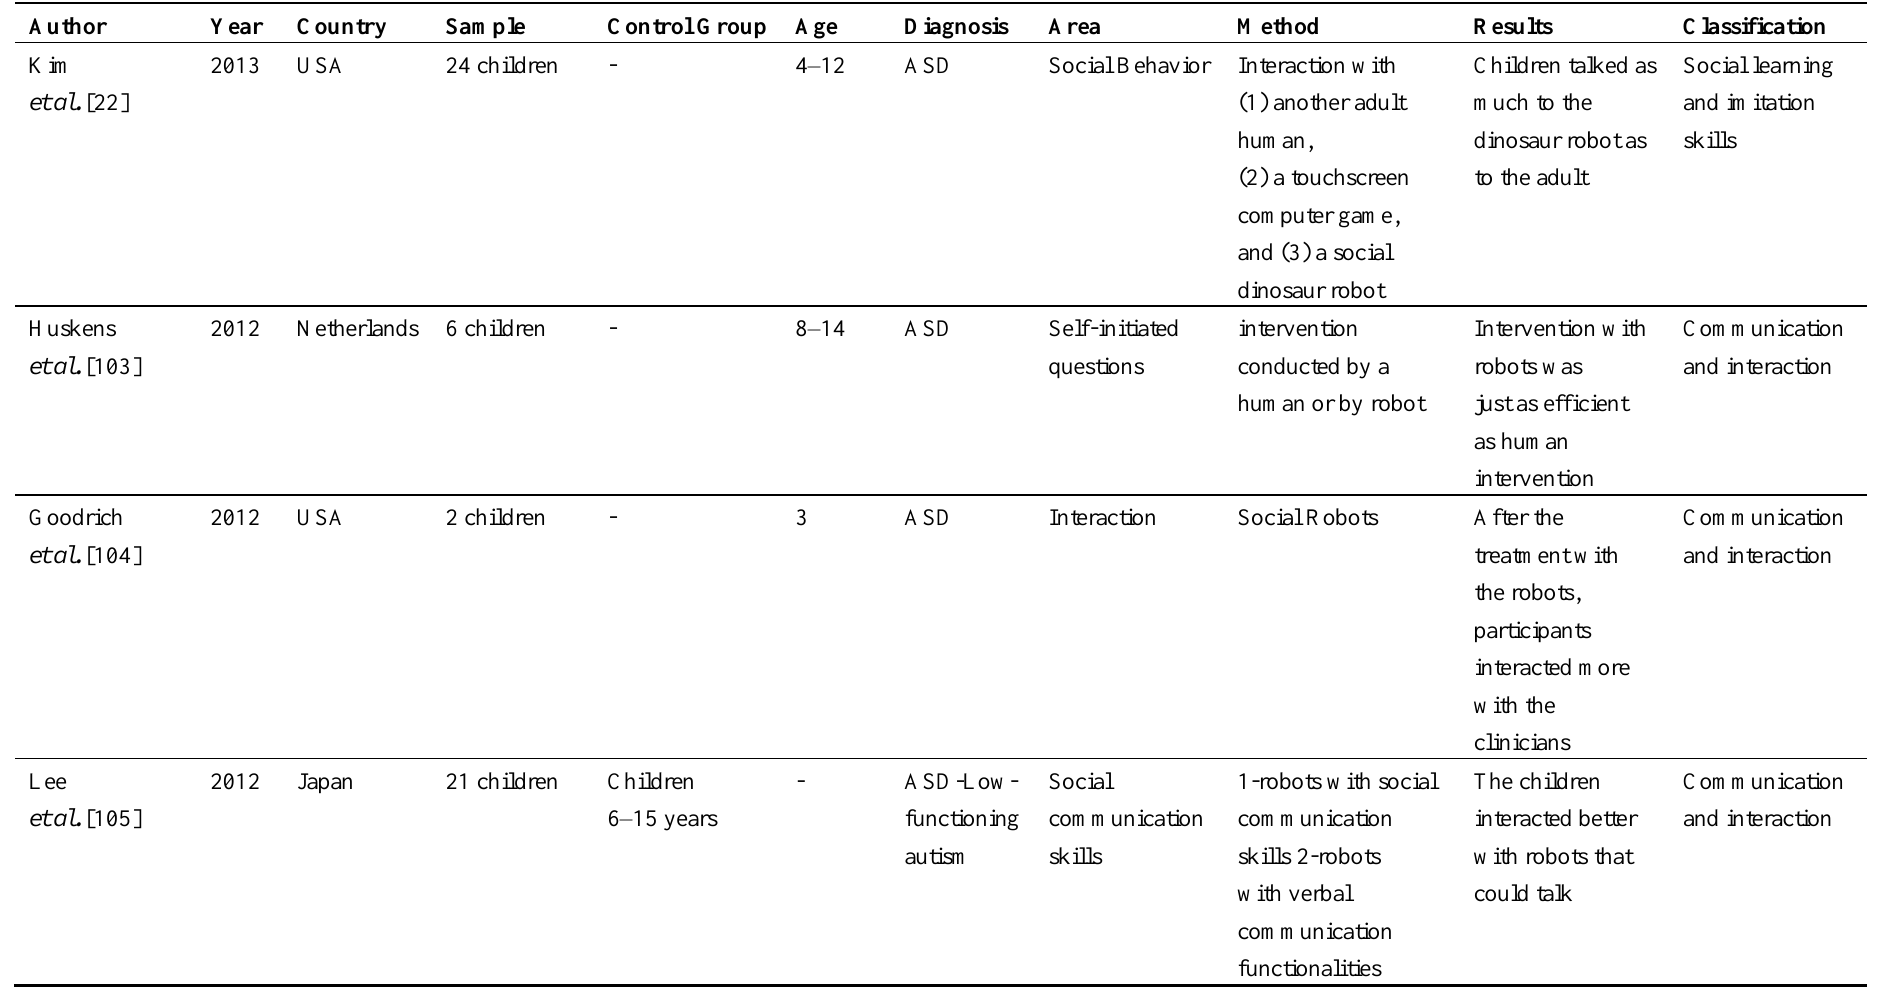
Table 4. Studies on the use of robots in therapy for children with